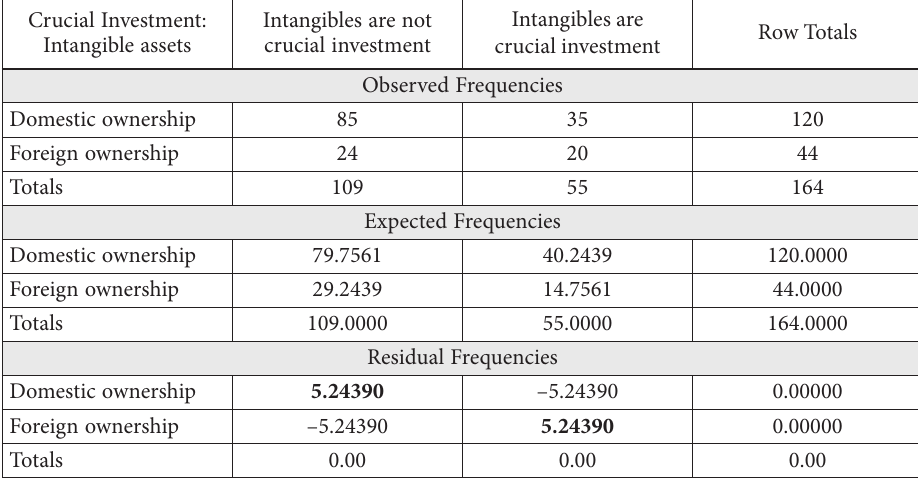
Table 8. Contingency: foreign ownership × intangibles – frequencies (source: own) Crucial Investment: Intangible assets